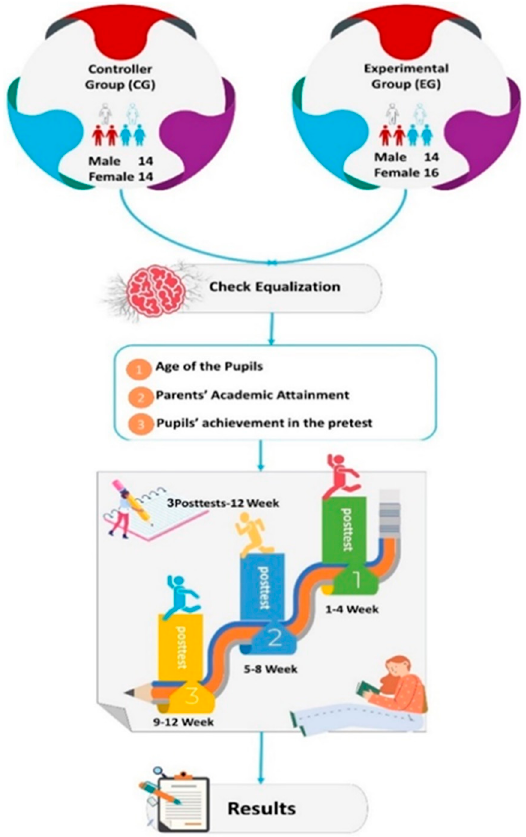
Figure 4. Experimental Design Overview